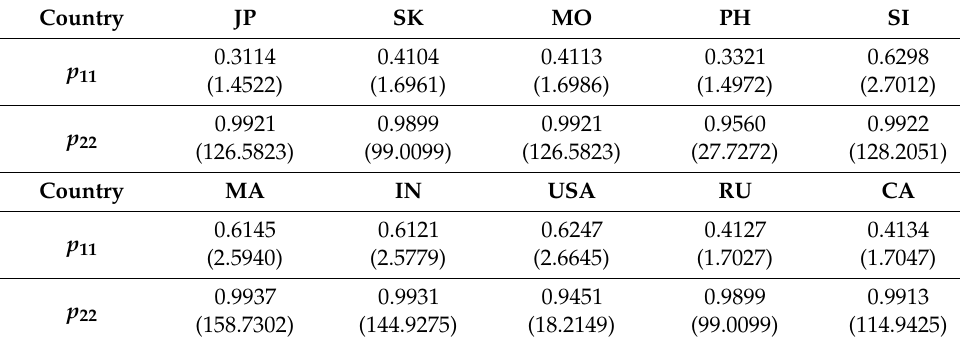
Table 5. The transition probabilities of the MS-model for ten